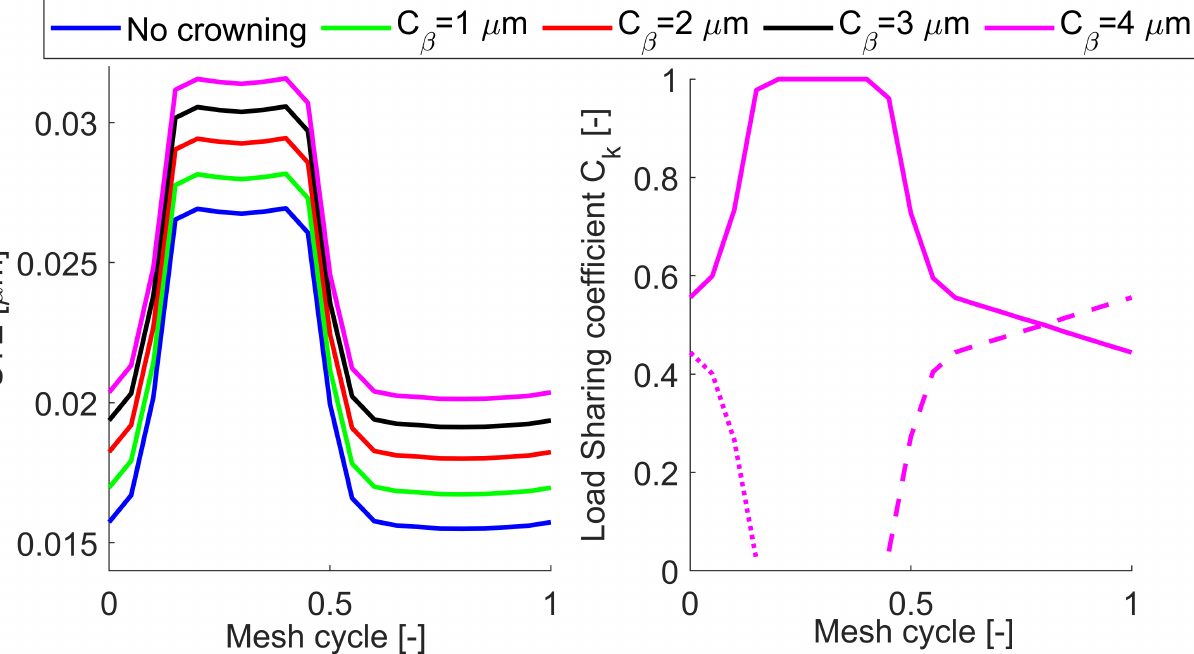
Figure 22. Effect of parabolic tip relief length of modification on the STE and load sharing in combination with face-width crowning C β = C β In = C β Fin , zL = b /2 and zLc = 0.8 b ( dCa = 94.245 mm and Ca = 32 µ m